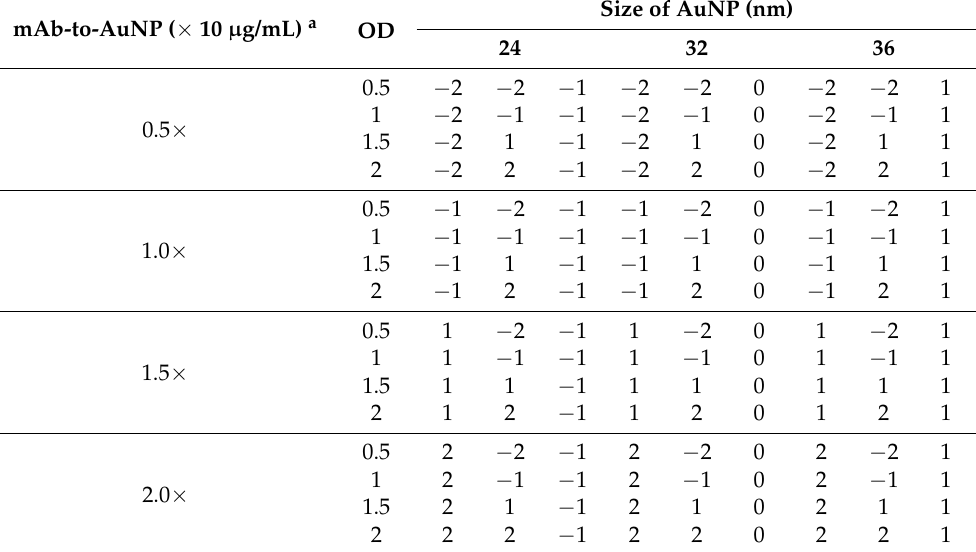
Table 1. The FF-DoE scheme for SE optimization. Each experiment was repeated twice. mAb-to-AuNP ( × 10 µ g/mL) a